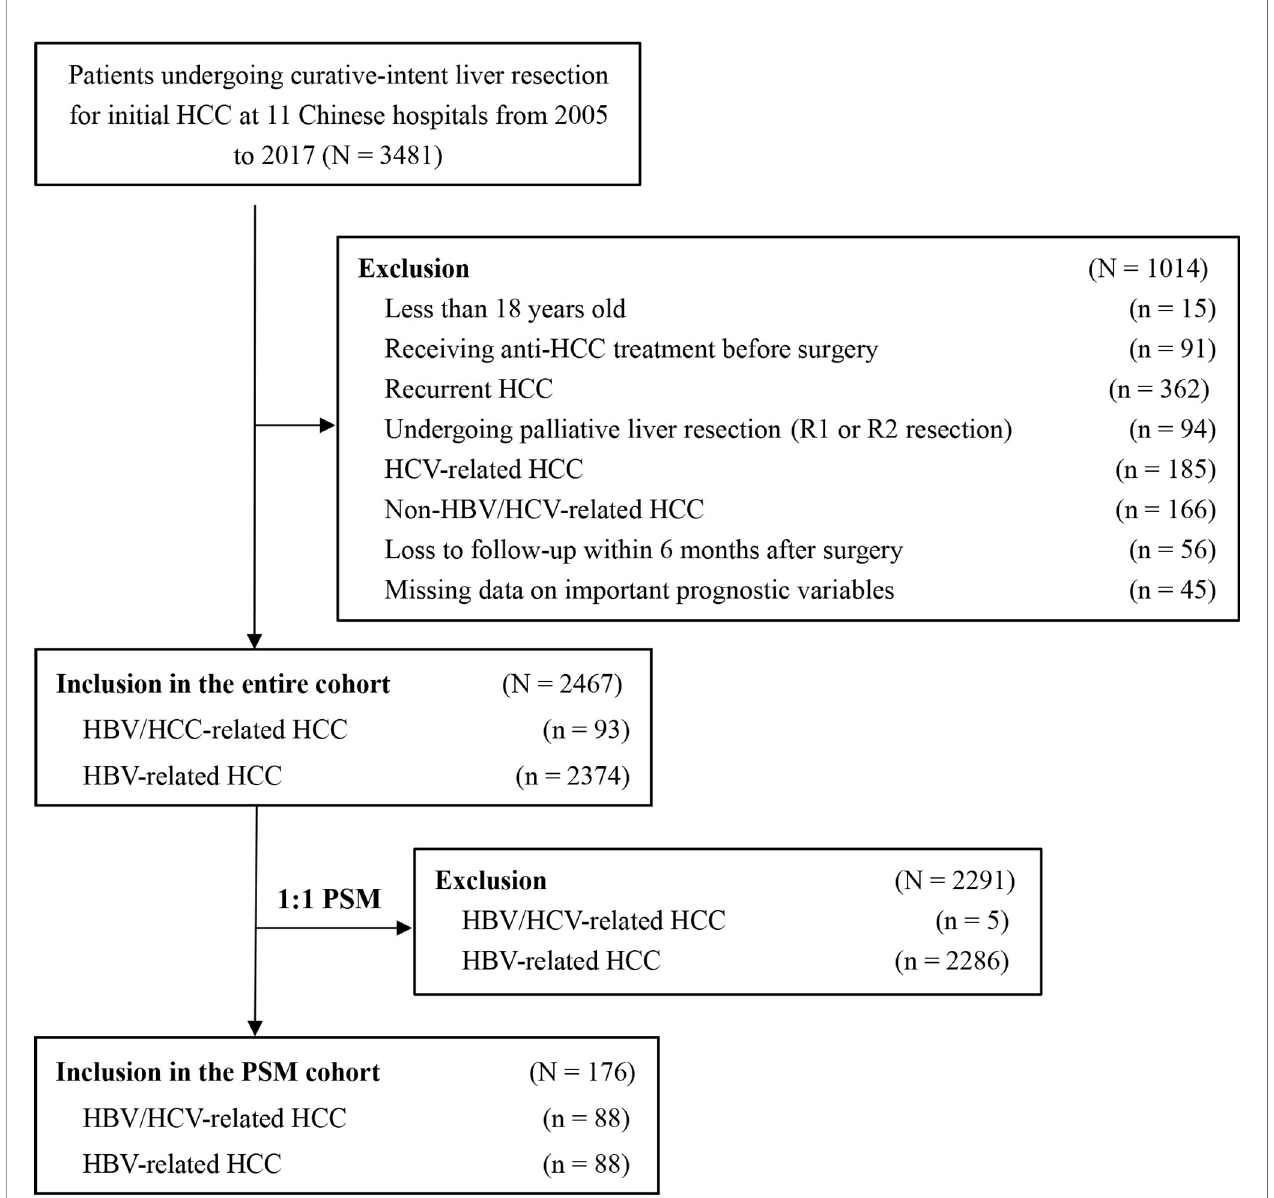
FIGURE 1 | Selection of the study